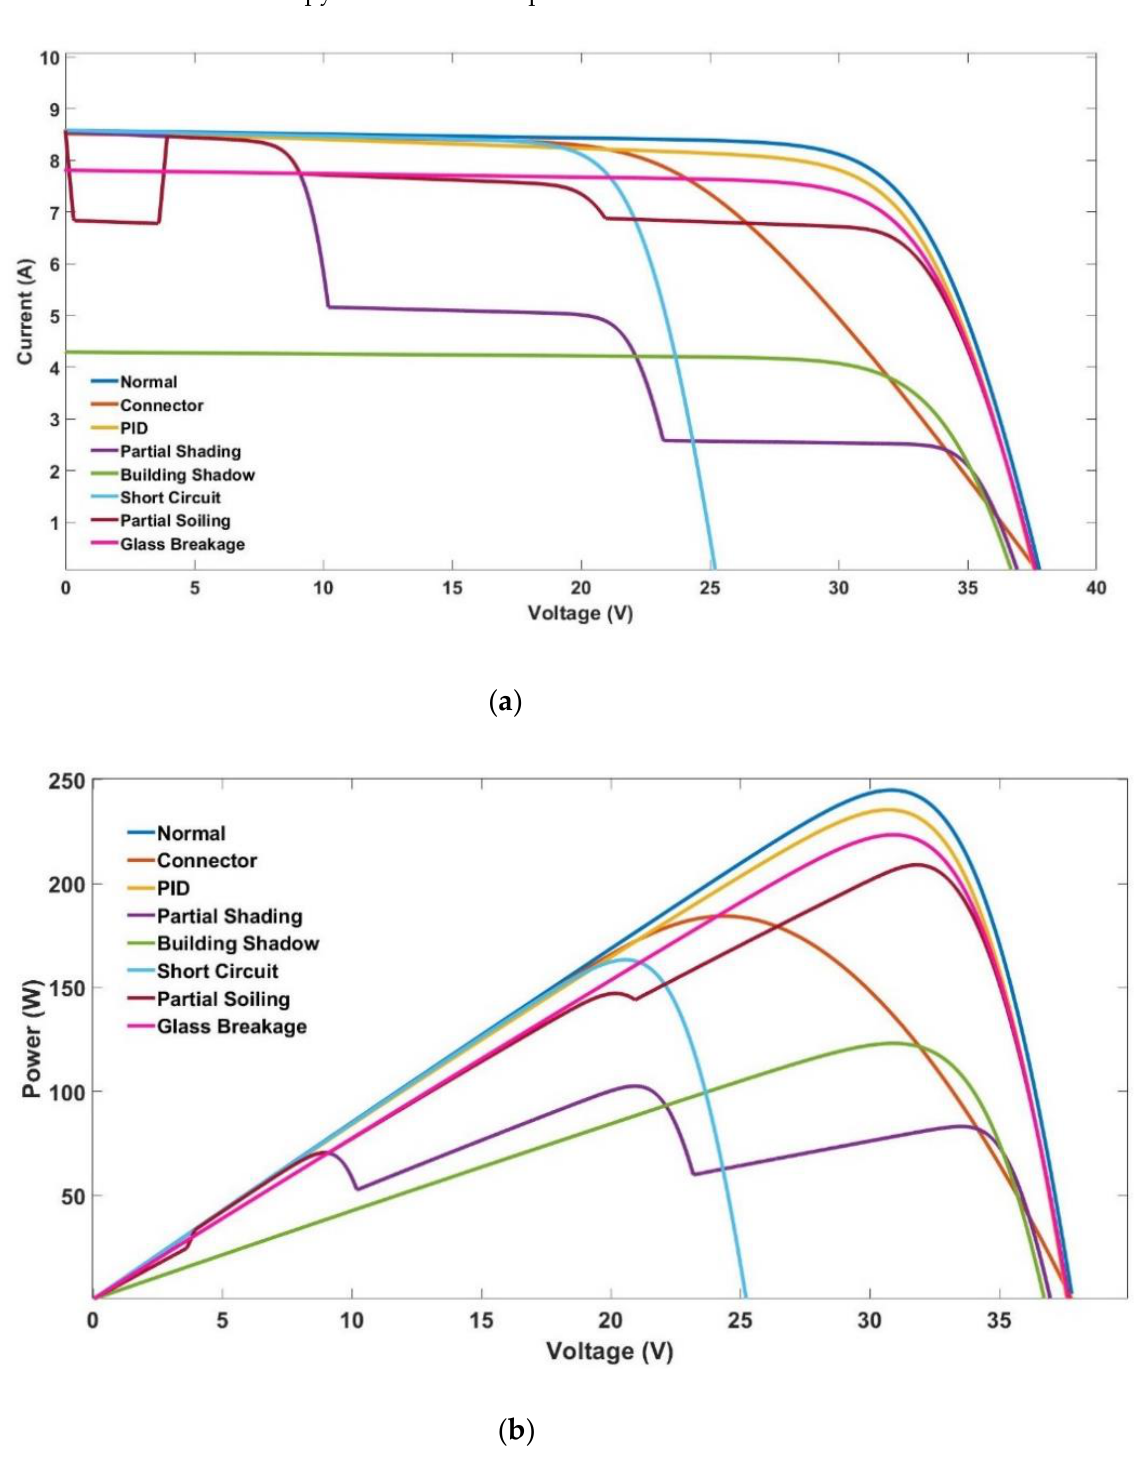
Figure 3. PV module outputs under faults and normal conditions: ( a ) I-V curve, and ( b ) P-V curve.